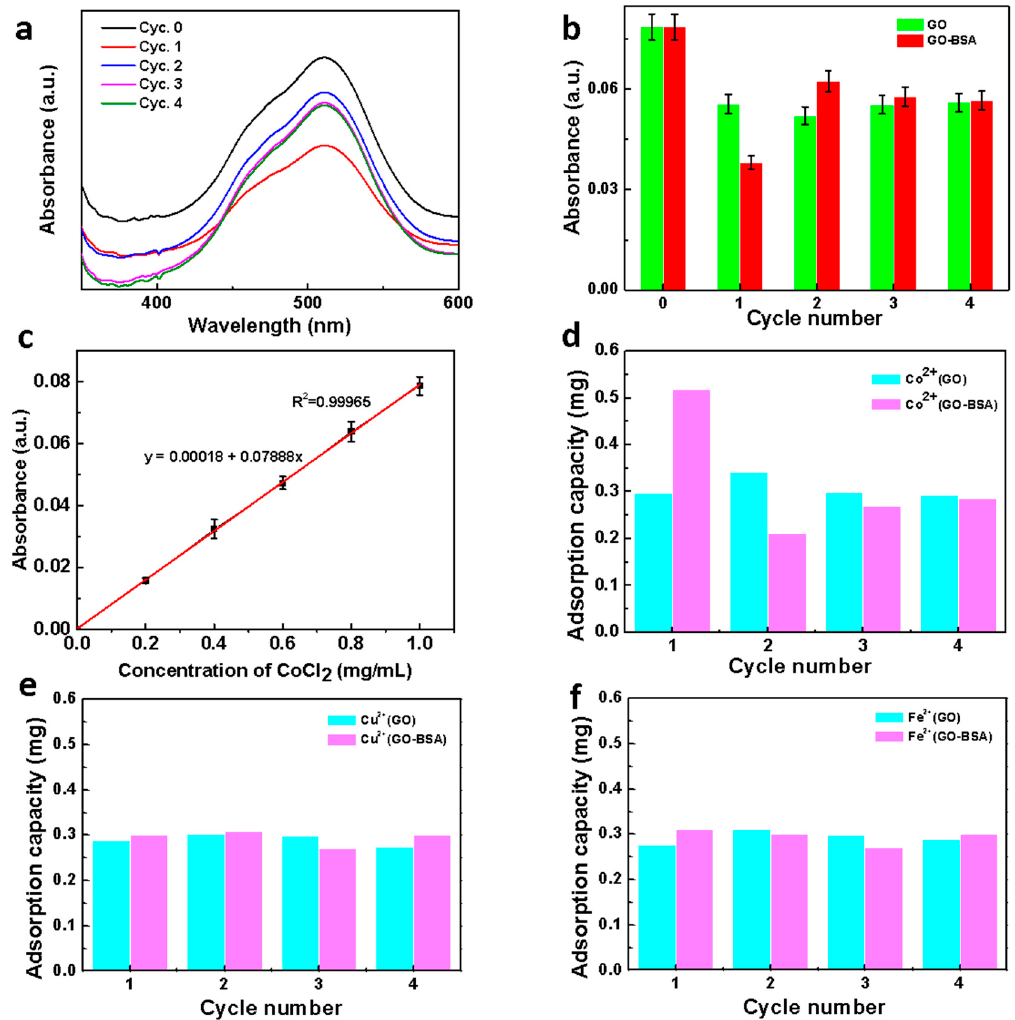
Figure 6. Removing other metallic ions: ( a ) the UV spectra of CoCl 2 before and after adsorbing by GO–BSA membrane; ( b ) the absorbance of CoCl 2 at 511 nm before and after adsorbing by GO–BSA membrane; ( c ) the standard curve of CoCl 2 at 511 nm; ( d ) the adsorption capacity of GO and GO–BSA filter membrane to CoCl 2 ; ( e ) the adsorption capacity of GO and GO–BSA filter membrane to CuCl 2 . ( f ) The adsorption capacity of GO and GO–BSA membrane to FeCl 2 .